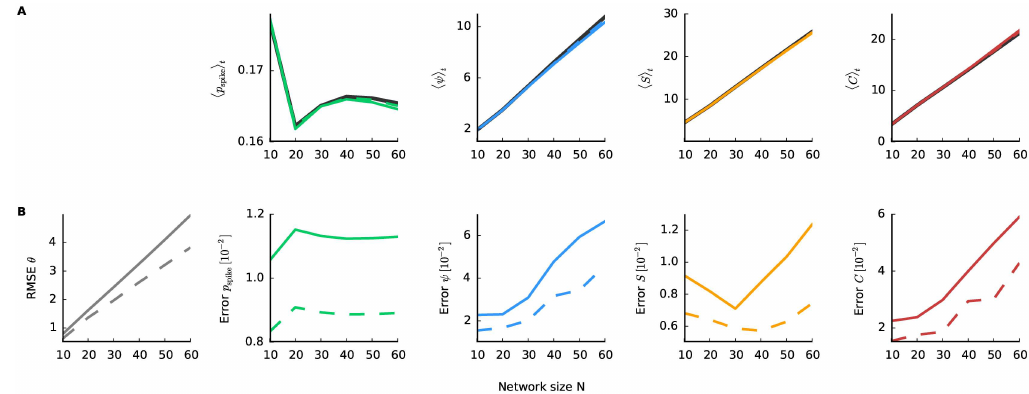
Fig 2. Approximation error and network size. Error analysison networks consistingof subpopulations with 10 neurons, constructed by the same procedure as in Fig 1. A : The averagevalue of the macroscopic propertiesover time as a function of network size. Black line is the true value, whilecolored lines show the estimated ones (solidline fit with 500 trials and dashedwith 1000trials) B : The correspondingerrors (only for θ t the RMSE is shown) for 500 trials (solid) and 1000 trials